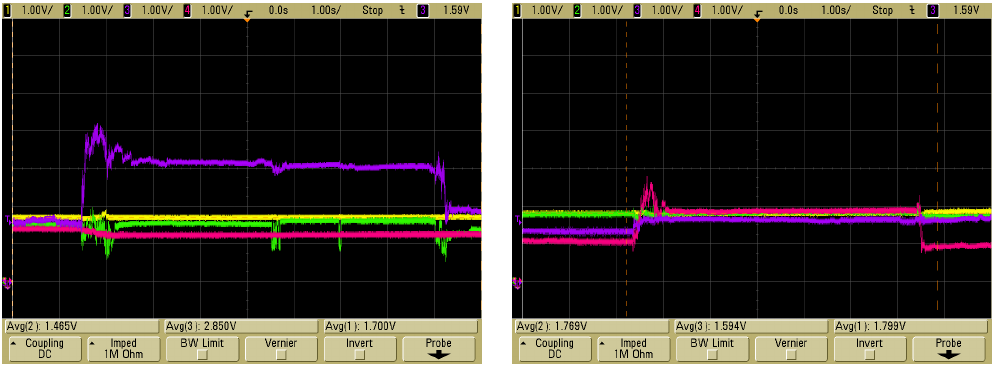
Figure 26. Response of strip 3 and strip